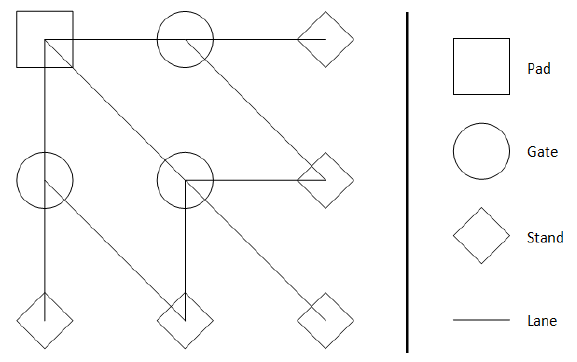
Figure A1. Schematic representation of one group of vertiport elements: 1 pad surrounded by 3 gates and 5 stands.